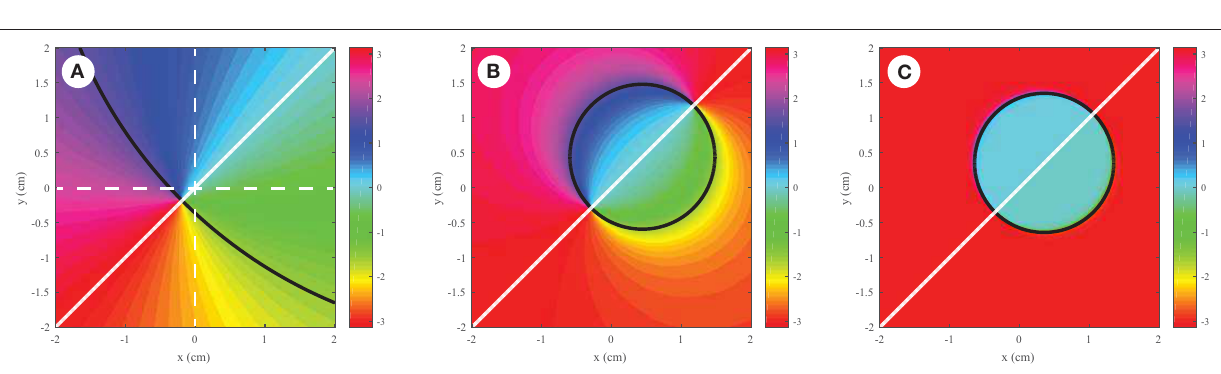
0.1 cm, (B) δ 0.5 cm, (C) δ 3 cm. Here t R 1, t L 0 and the = = = = =